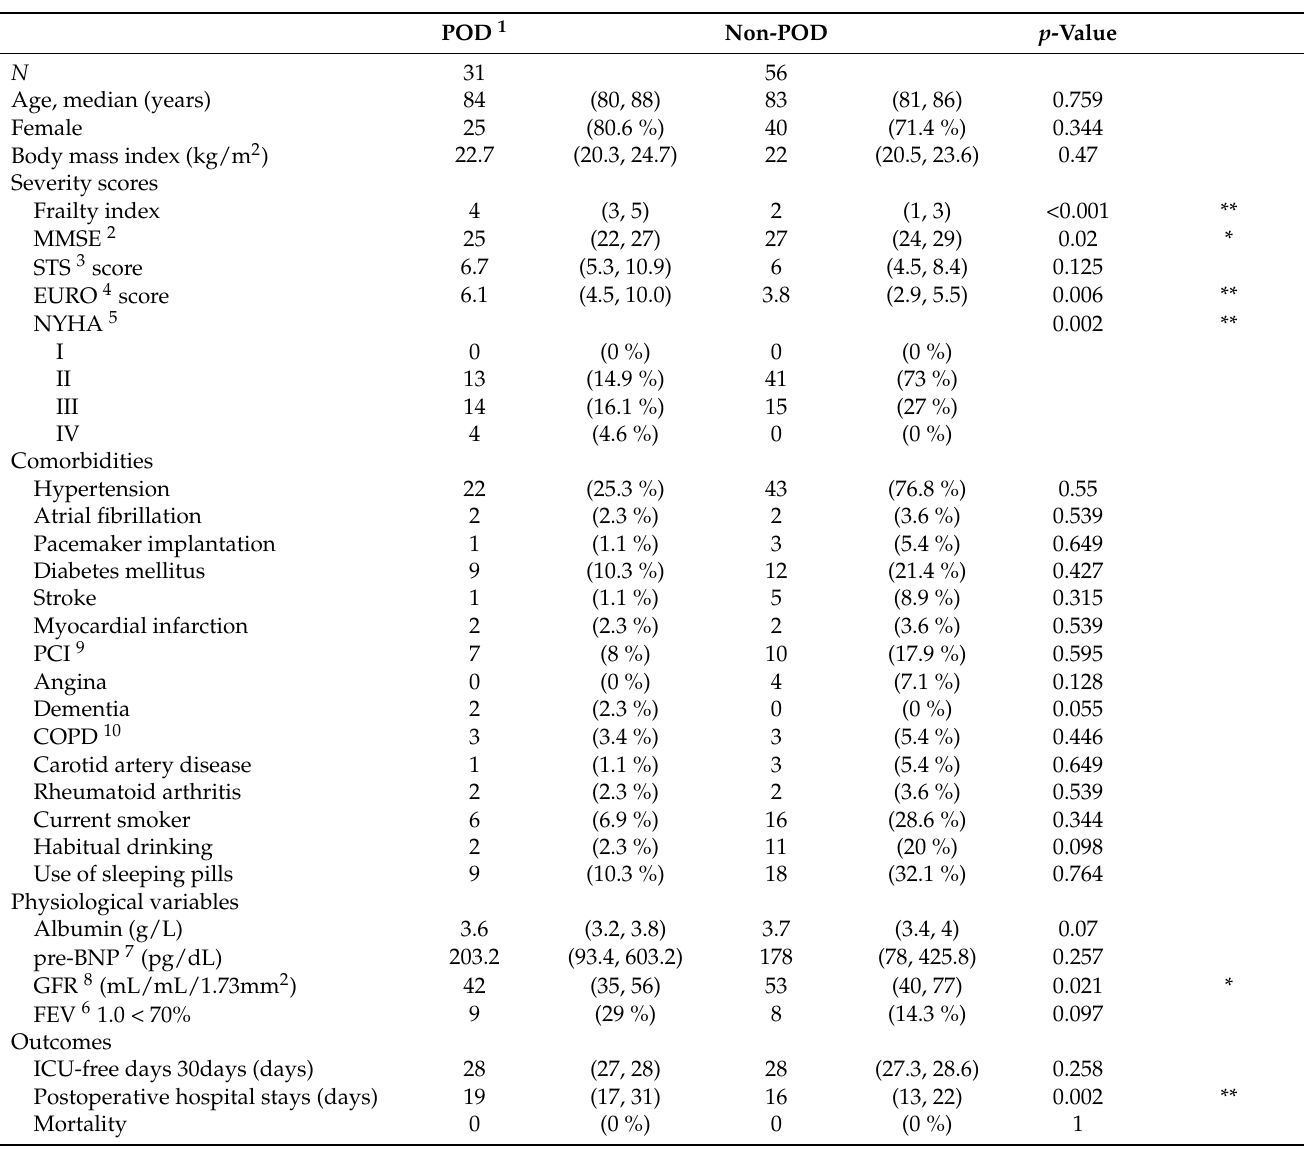
Patient characteristics in the POD and non-POD groups are shown separately. Values represent the number of patients (rates) or median (interquartile range). The Wilcoxon test and Fisher’s exact test were used to compare data between POD and non-POD patients. * p < 0.05, ** p < 0.01. 1 POD, postoperative delirium; 2 MMSE, Mini-Mental State Examination; 3 STS, Society of Thoracic Surgeons; 4 EURO, European System for